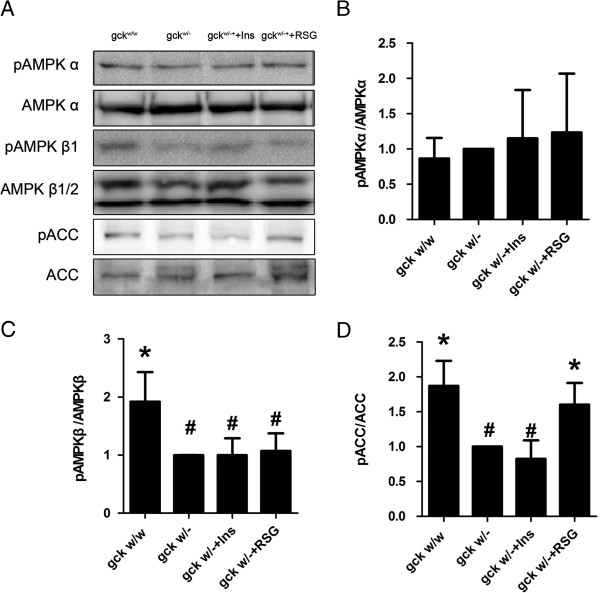
Levels of phosphorylated AMPK and ACC in the hearts of 60-week old liver-specific gck knockout mice. Representative Western blot images (A) and quantification of the levels of p-AMPKα/AMPKα (B), p-AMPKβ/AMPKβ (C), and p-ACC/ACC (D) in heart homogenates of wild-type (gckw/w) and gck knockout (gckw/–) mice as well as knockout mice treated with insulin or rosiglitazone for 4 weeks are shown. Phosphorylated AMPK and ACC levels were measured by Western blots. n = 3 for all samples. Asterisk (*) refers to statistical significance (P < 0.05) in comparisons with gckw/– mice, while # refers to comparisons with gckw/w mice.